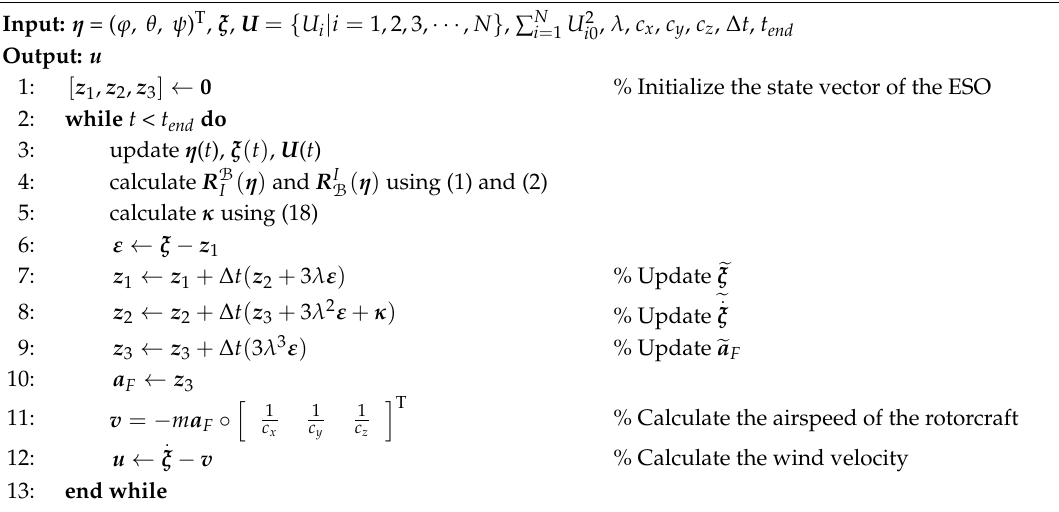
Algorithm 1: Computational procedure of the wind estimation